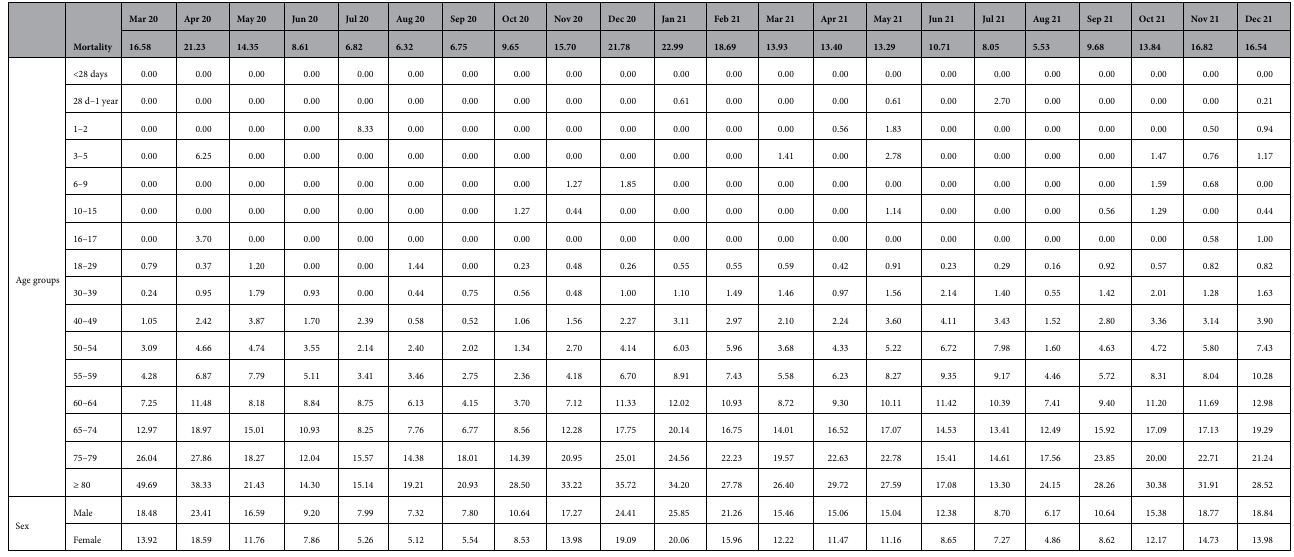
Table 4. Mortality. Mortality [%] over time by age subgroups from January 2020 to end of December